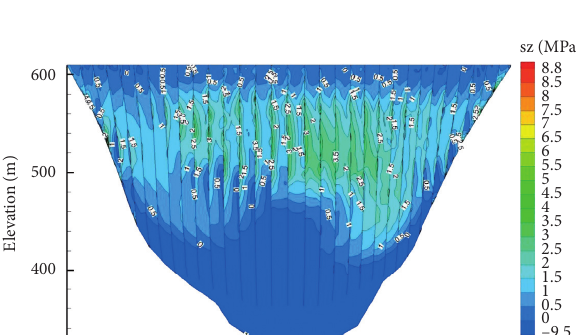
Figure 26: Envelope of maximum static and dynamic vertical stress distribution of downstream surface of the dam for relative sliding condition.